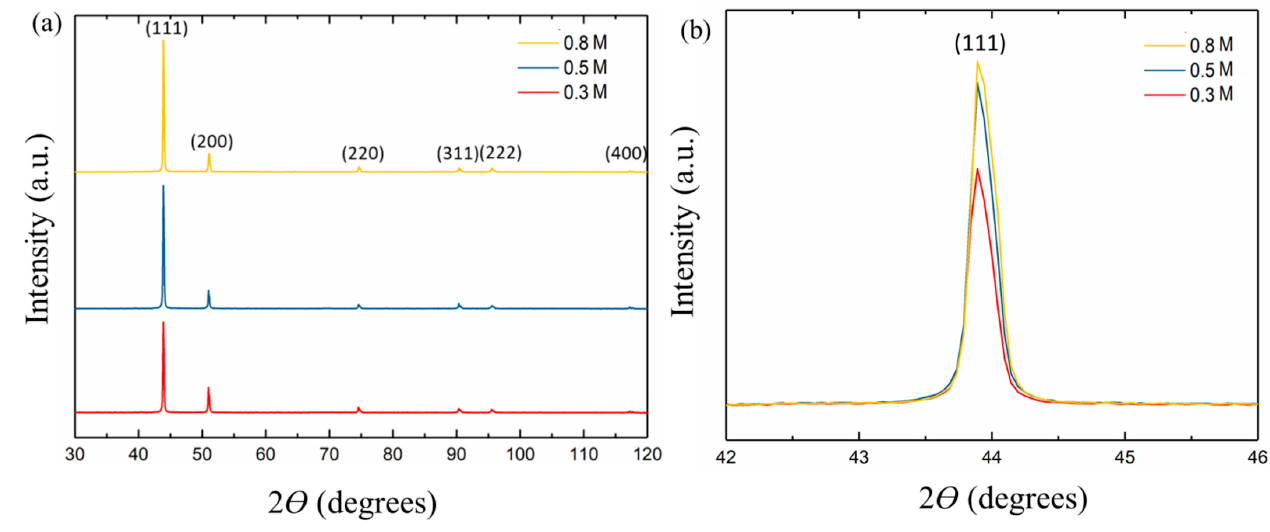
Figure 8. ( a ) XRD patterns and ( b ) (111) intensities of the 15- µ m thick nt-Cu foils electroplated with different Cu 2+ concentrations.